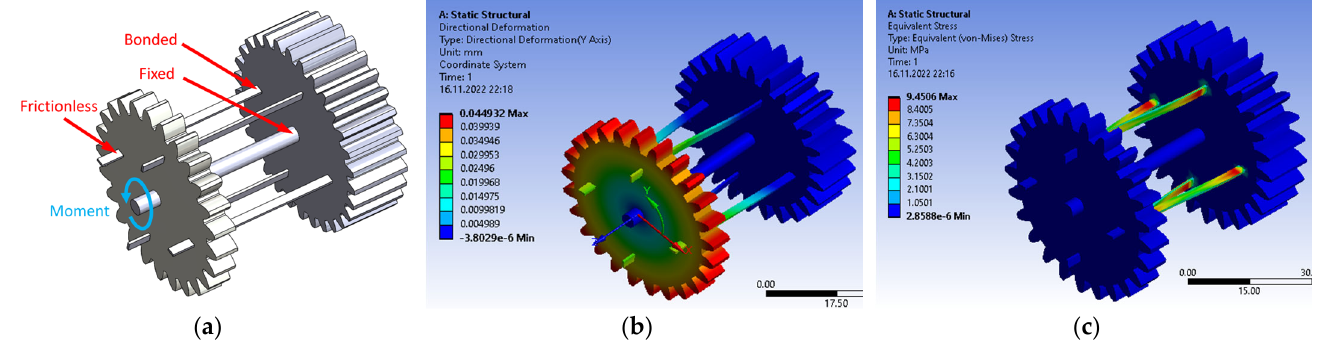
Figure 4. Representative plots: ( a ) boundary conditions ( b ) directional deformation about the Y axis, and ( c ) Von-Mises’s distribution on the elastic clutch.